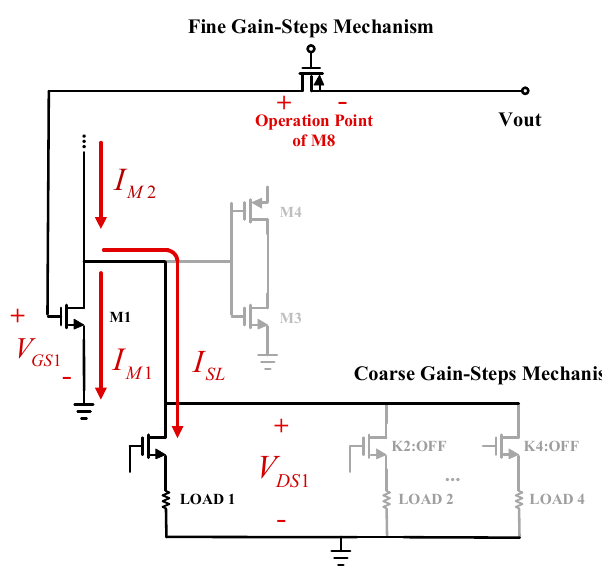
Figure 4. The gain-selection mechanism of the proposed TIA.